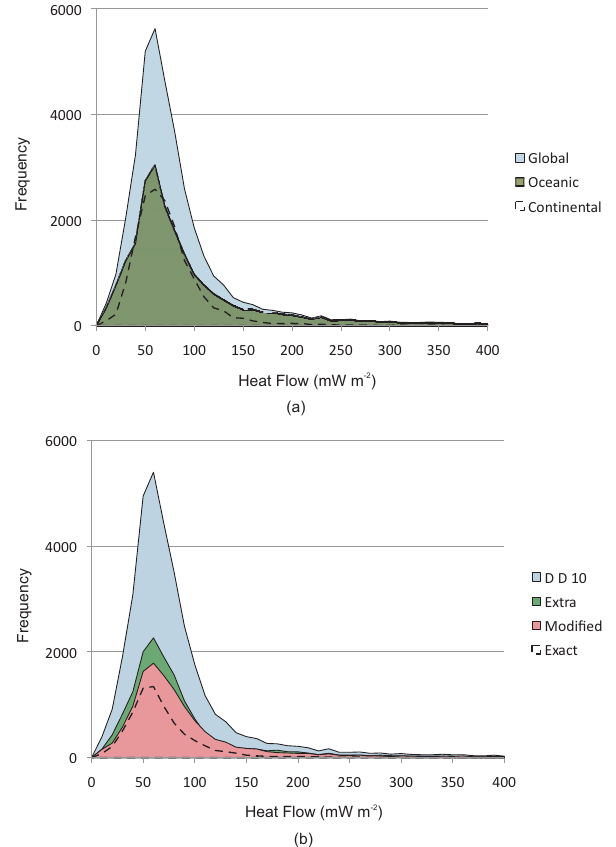
Fig. 3. (a) Histogram of heat flow measurements (global, oceanic and continental) grouped by value of measurement, in bins of 10. (b) A breakdown of the data-set used in this study (DD10), into those points replicated in PHJ93 (exact), those points modified from PHJ93 (modified) and additional points